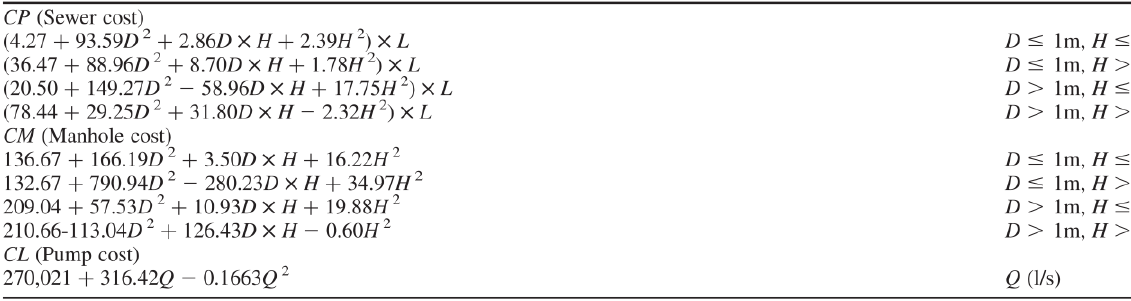
Table 1. The cost function of the example in Yuan (Li and Matthew 1990).